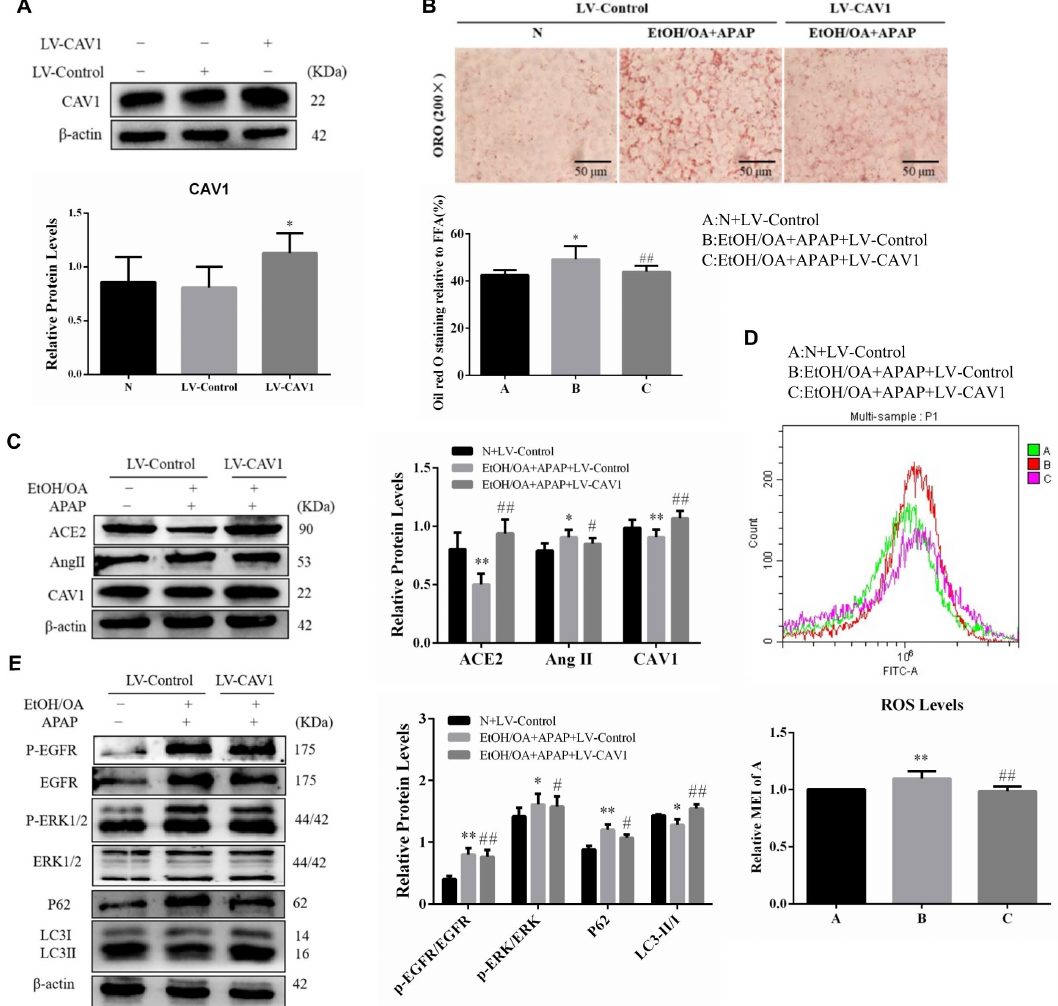
Figure 6. CAV1 alleviated lipid deposition, suppressed the Ang II/EGFR/ERK signaling and restored autophagic flux in EtOH/OA and APAP treated L02 cells. ( A ) Western blot analysis of CAV1 protein levels. ( B ) Representative images of ORO staining of lipid droplets in L02 cells (Scale bar = 50 μm). ( C ) Western blot analysis of ACE2, Ang II and CAV1 protein levels. ( D ) ROS levels. ( E ) Western blot analysis of p-EGFR/EGFR, p- ERK/ERK, P62 and LC3 II / I protein levels. Data represent the mean ± SEM ( n = 3 independent experiments). * p < 0.05 vs. N + LV-Control group; ** p < 0.01 vs. N + LV-Control group; # p < 0.05 and ## p < 0.01 vs. EtOH/OA + APAP + LV-Control group.